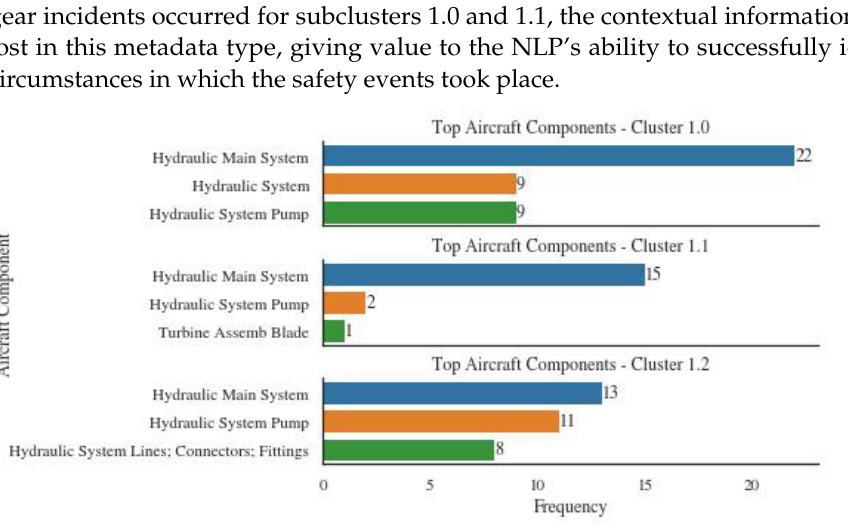
Figure 9. Cluster 1 Subclusters’ Aircraft Component Metadata